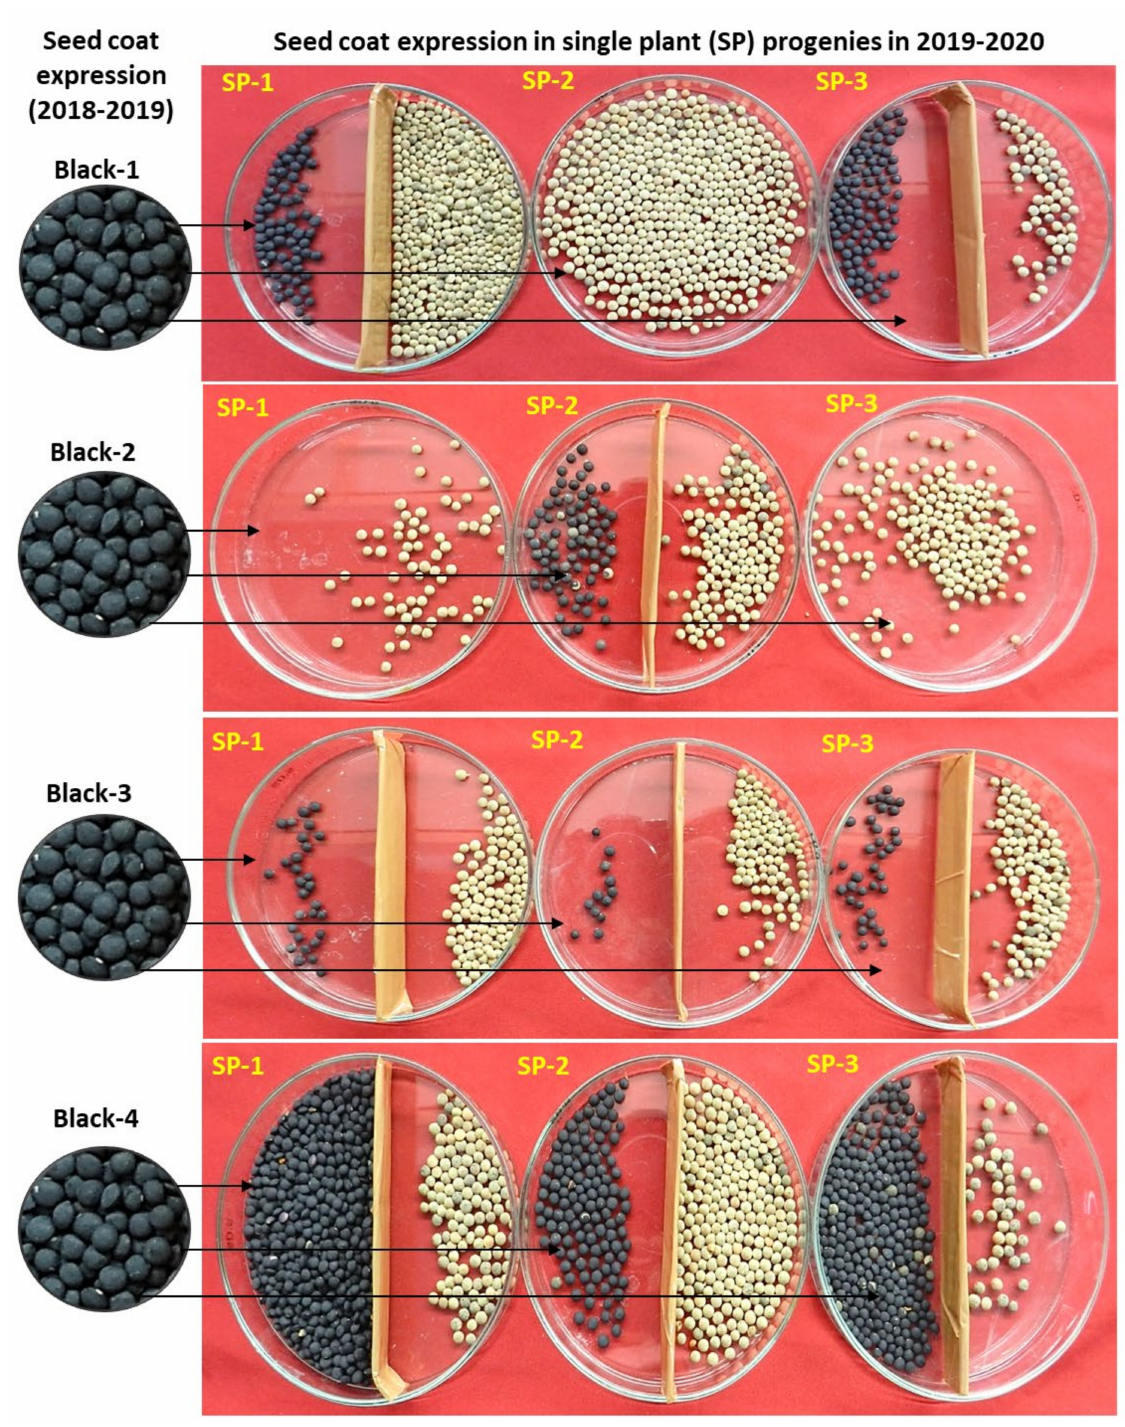
Figure 3. Seed-coat expression of three single plants (SP-1 to SP-3) in the year 2019–2020 derived from the four plants seeds (L4717-NM) having black seed-coat expression (Black-1 to Black-4) in the year 2018–2019. Black/spotted and brown seed-coat colored seeds (if formed) were separated in a Petri plate (obtained from a single plant) for more clarity of their relative frequencies per